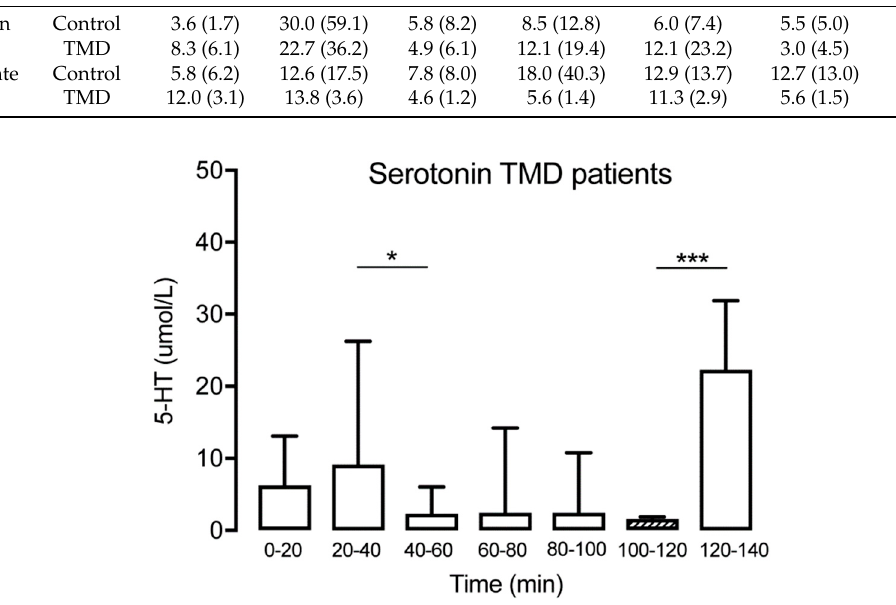
Figure 3. Interstitial serotonin at the different time points for the TMD group ( n = 15) showing a significant decrease at T40–60 followed by a spontaneous increase at T120–140. The hatched box indicates time point T100–120, often used as a baseline. It was not possible to extract data from 4 of the 15 participants regarding the 5-HT levels at T0-20 due to technical difficulties. * indicates p < 0.05 and *** indicates p < 0.001.